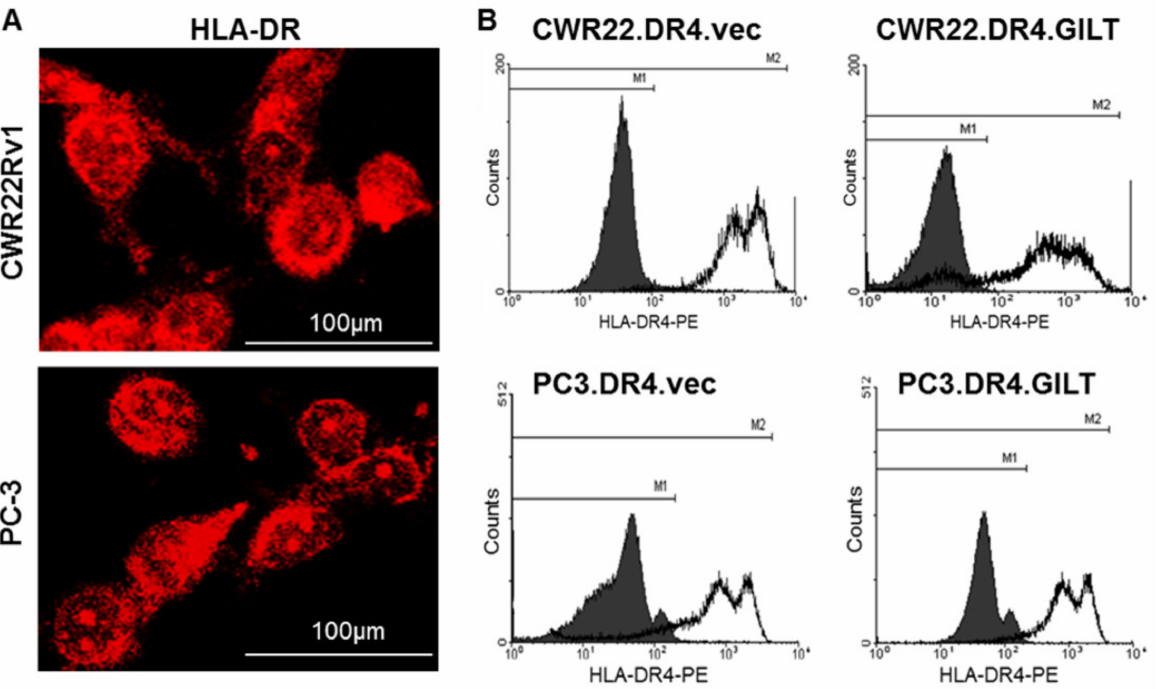
Figure 3. GILT insertion did not significantly alter HLA class II protein expression in human prostate cancer cells. ( A ) The expression of HLA-DR was tested in CWR22Rv1 and PC-3 prostate cancer cell lines by immunofluorescent staining (red) with the anti-HLA-DR antibodies (L243), followed by confocal microscopy. ( B ) CWR22Rv1, CWR22Rv1.GILT, PC-3, and PC-3.GILT cells were transduced with HLA-DR4 by retroviral transduction and stained with anti-DR4 antibodies (359-F10). Cells were then analyzed by flow cytometry for HLA-DR4 expression. IN-1 was used as an isotype control. Data are representative of three separate